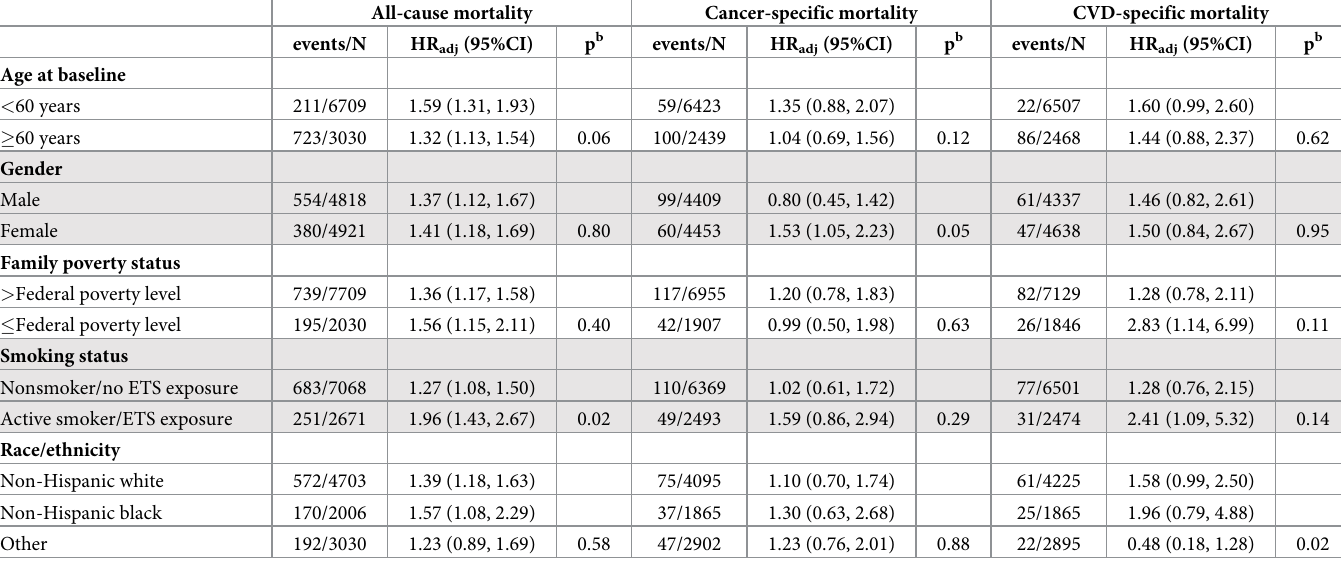
Table 4. Assessment of effect heterogeneity or effect measure modification for log-transformed S OH-PAHs (nmol/L) concentrations and mortality by age, gender, family poverty status, smoking status, and race/ethnicity a .